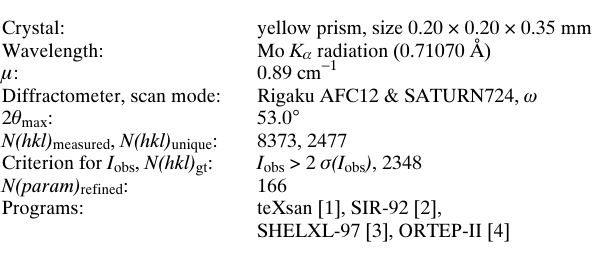
Table 1. Data collection and handling.